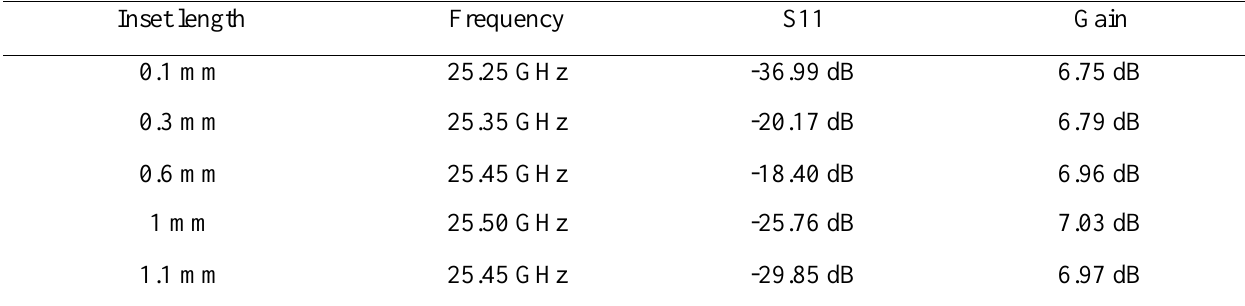
Table 1. Changing the length of